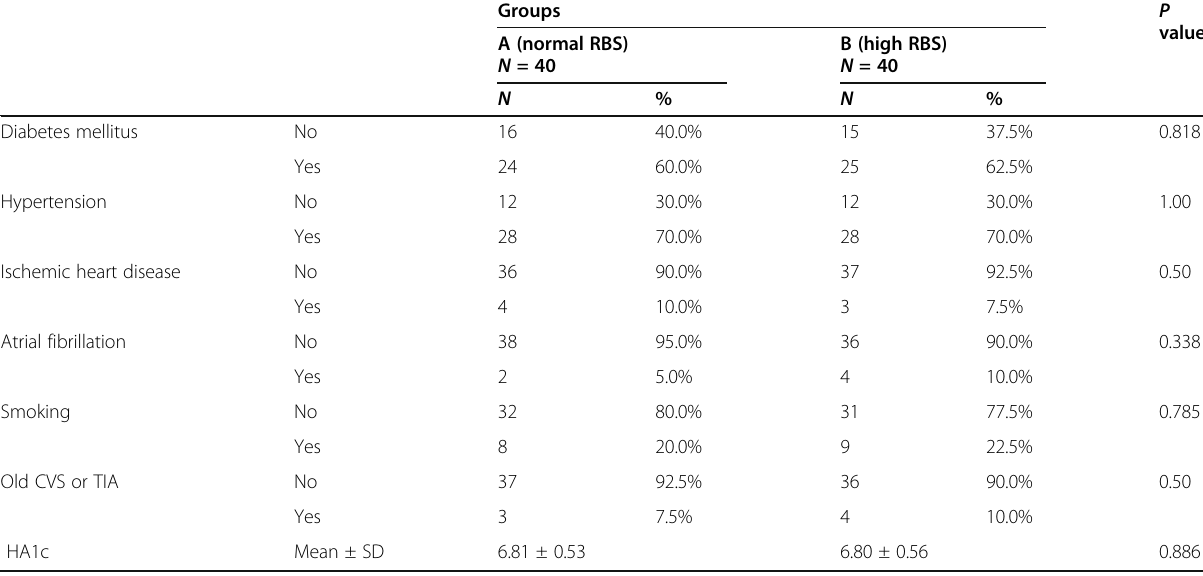
Table 2 Comorbidities in the studied groups